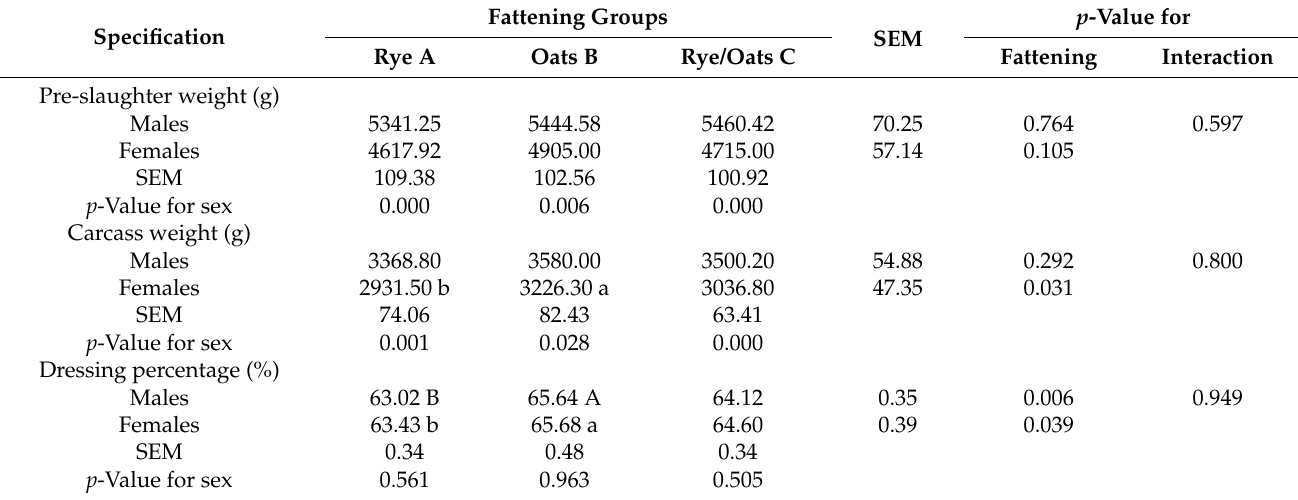
Table 3. Mean of the slaughter traits of geese fattened by feeding hybrid rye or oats.